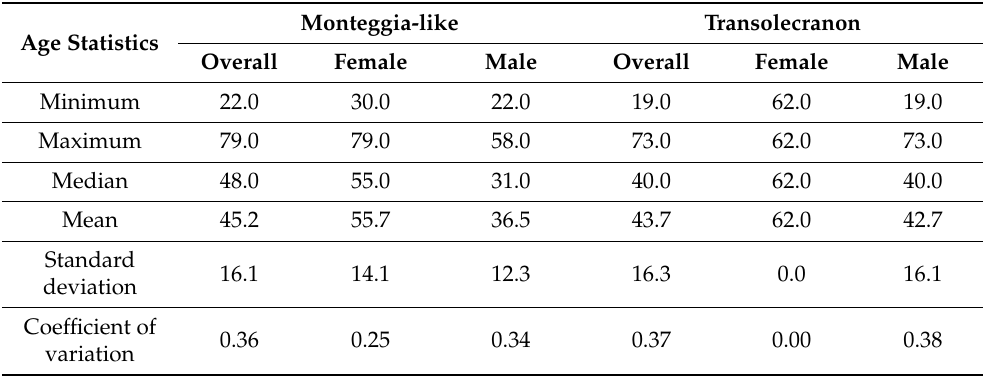
Table 1. Age distribution for specific